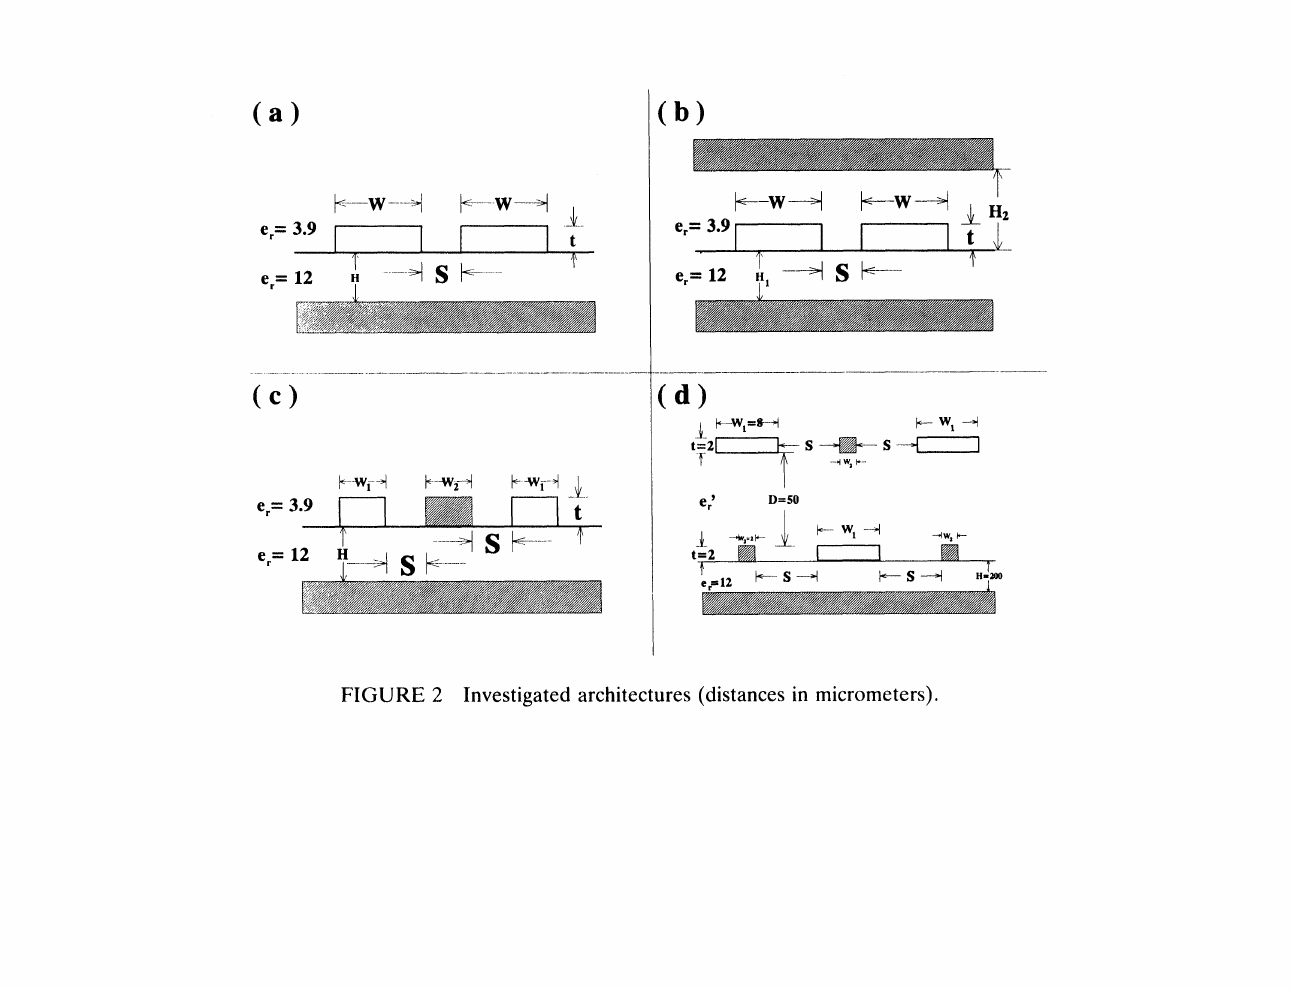
FIGURE 2 Investigated architectures (distances in